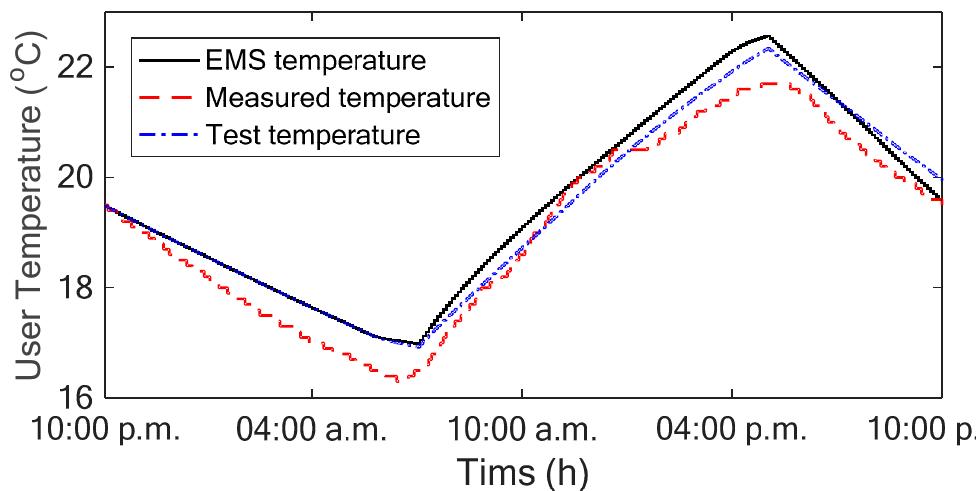
Figure 11. Room temperature comparison (measured against calculated applying the model fed with the optimal and the measured power profile).